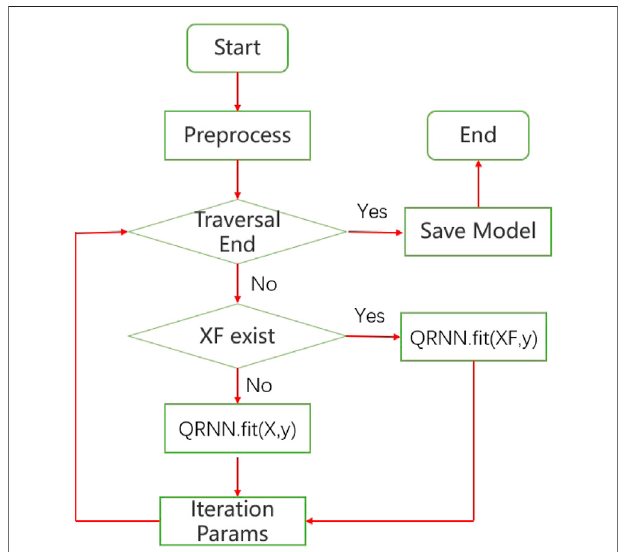
FIGURE 5 | The overall algorithm of QRNN.